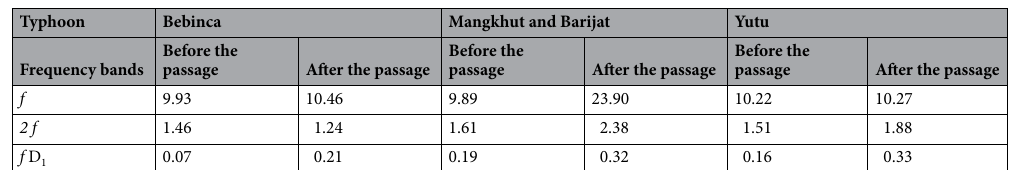
Table 2. Average proportion of the depth-averaged NIKE, 2 f and f D 1 energy of band in total KE during the passage of typhoons.